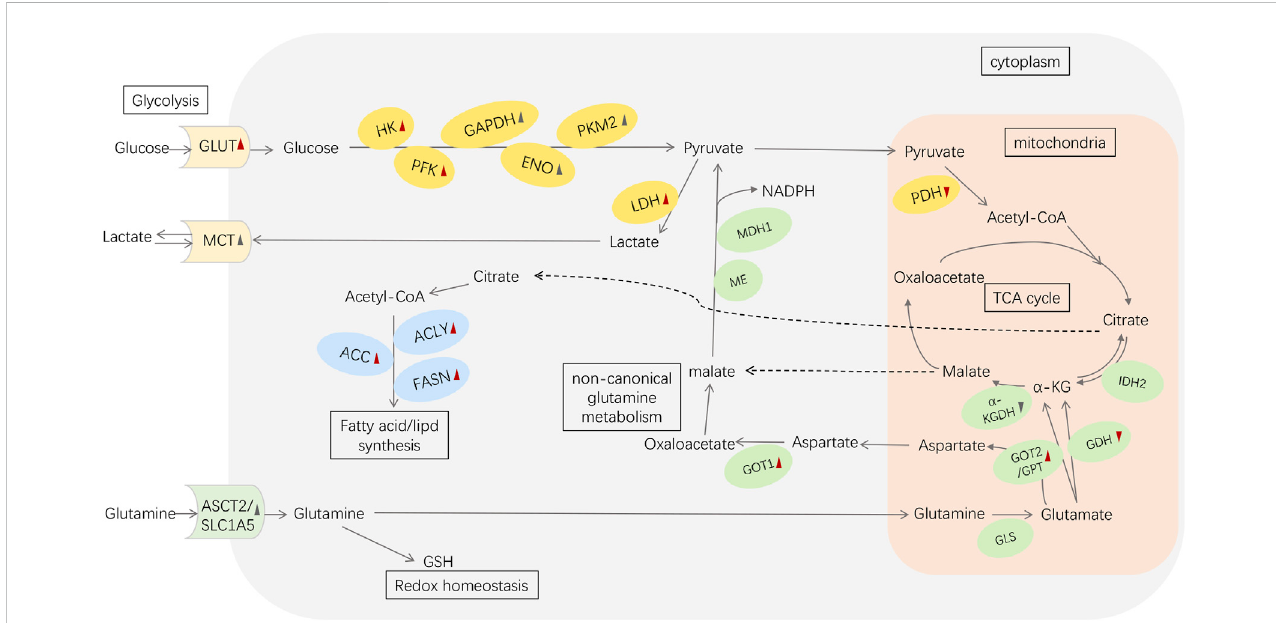
FIGURE 1 Metabolicreprogramminginpancreaticcancer.RedarrowheadsrepresenttheeffectsinducedbymutantKRAS:upwardmeansupregulation;downward meansdownregulation.Theblacksymbolsrepresentthechangesinducedbyotherreasons(e.g.,HIF-1 α 、 c-MYC).Abbreviations:GLUT,glucosetransporter; HK, hexokinase; PFK, phosphofructokinase; GAPDH, glyceraldehyde-3-phosphate dehydrogenase; ENO, enolase; PK, pyruvate kinase; LDH, lactate dehydrogenase; MCT, monocarboxylic acid transporters; PDH, pyruvate dehydrogenase; α -KG, α -ketoglutarate; ASCT2/SLC1A5, alanine/serine/ cysteine transporter 2/SLC1A5; GSH, glutathione; GLS, glutaminase; GDH, glutamate dehydrogenase; IDH2, isocitrate dehydrogenase 2; GOT1, aspartate transaminase 1; GOT2, aspartate transaminase 2; GPT, alanine transaminase; α -KGDH, α -KG dehydrogenase; ME, malic enzyme; MDH1, malate dehydrogenase 1; ACLY, ATP-citrate lyase; ACC, acetyl CoA carboxylase; FASN, fatty acid